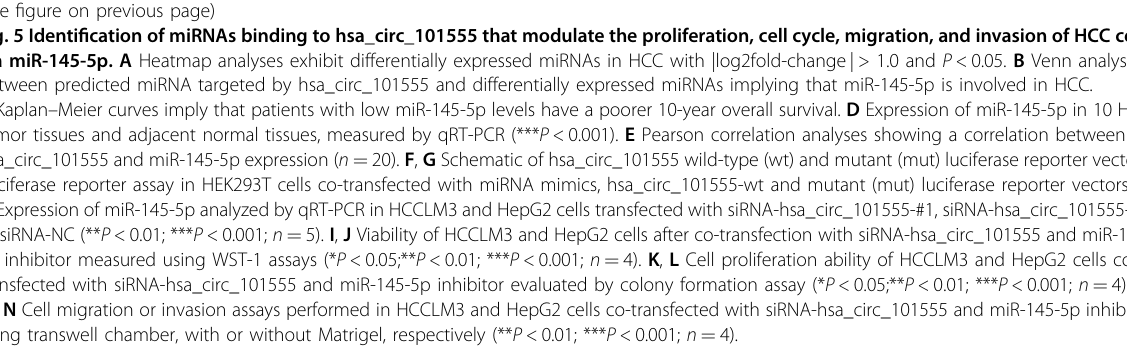
(Fig. 5F – G). These fi ndings indicate that hsa_circ_101555 may act as a sponge for miR-145-5p.